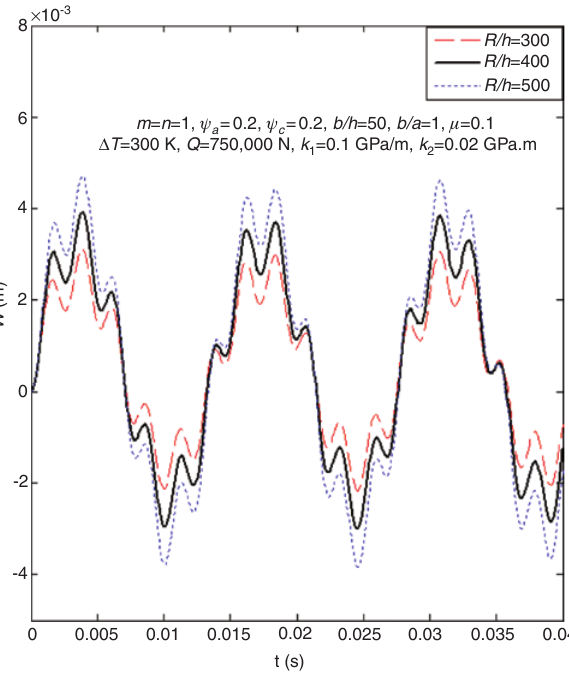
Figure 6: Effect of the R / h ratio on the non-linear dynamic response of the polymer composite cylindrical panel.